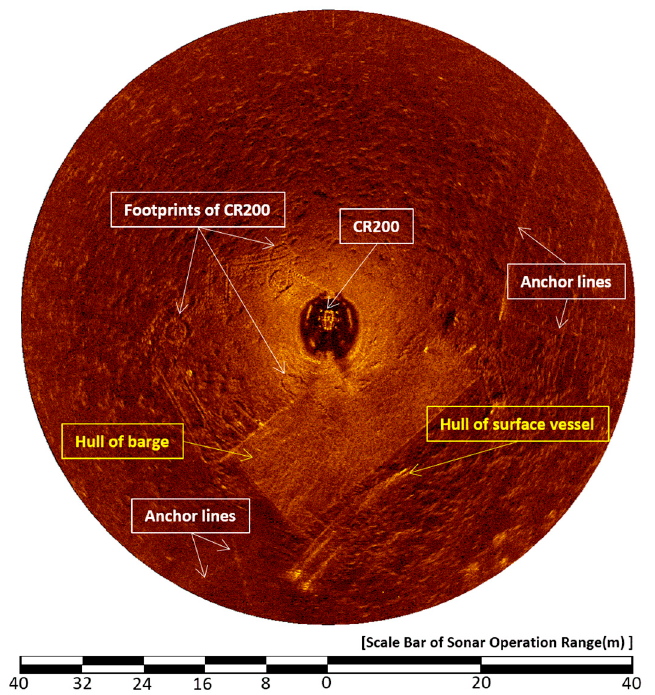
Figure 21. The 6° downward HHM sonar image under the support barge. Figure 21. The 6 ◦ downward HHM sonar image under the support